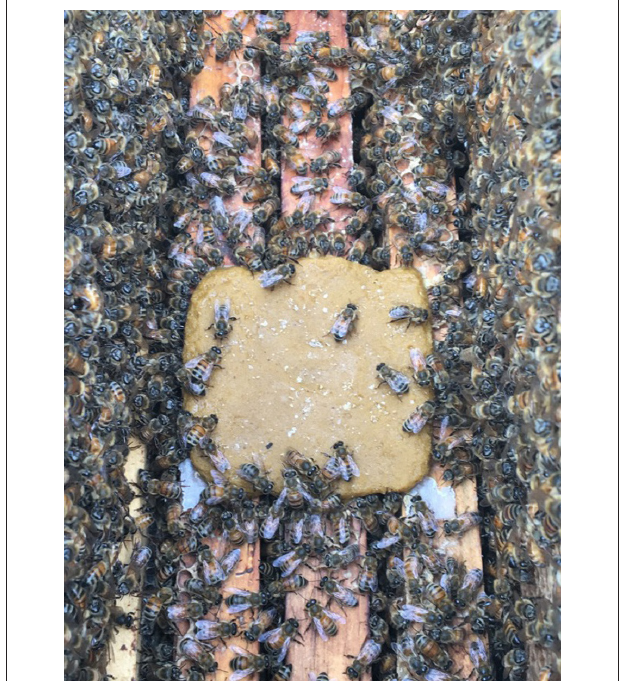
FIGURE 1 | A pollen substitute patty placed above the brood nest of a honey bee